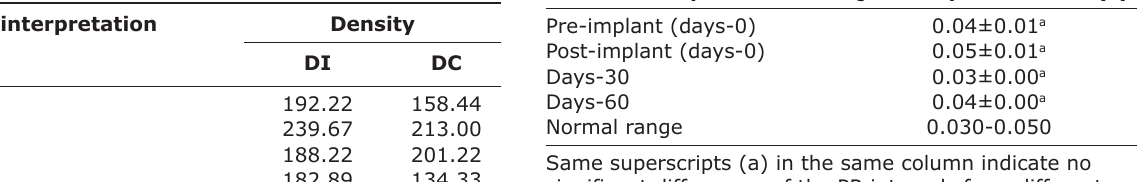
Table-5: Radiographic density of peri-implant (arbitrary unit) based on time of interpretation (days).